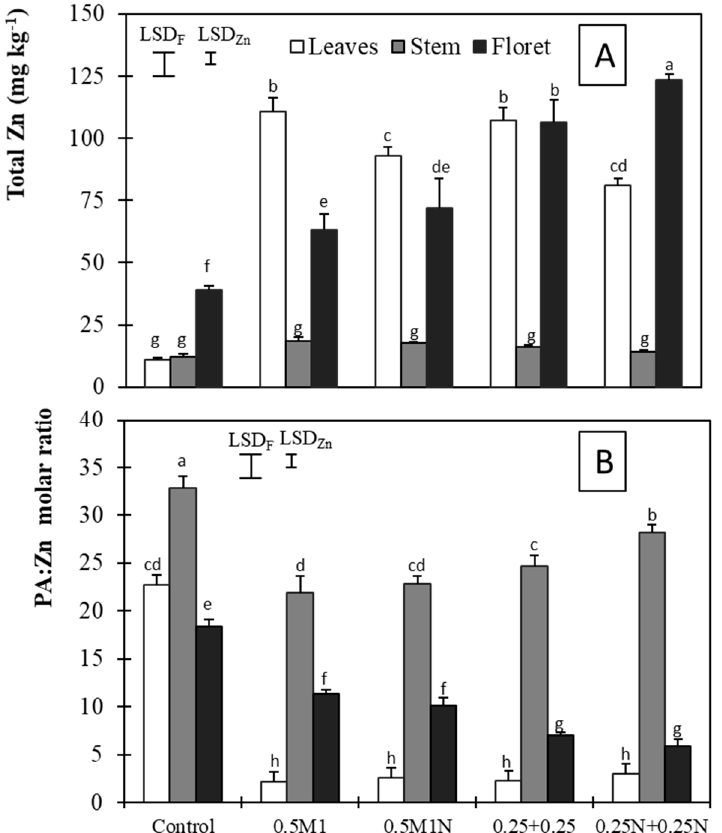
Figure 1. Total Zn (mg kg − 1 ) ( A ) and PA:Zn molar ratio ( B ) ± standard error of the mean. Vertical bars represent LSD ( p < 0.05) for comparison. LSDF: same broccoli fraction; LSD Zn : same Zn treatment. Different letters represent a significant difference at the p < 0.05 level for each broccoli fraction and Zn treatment.